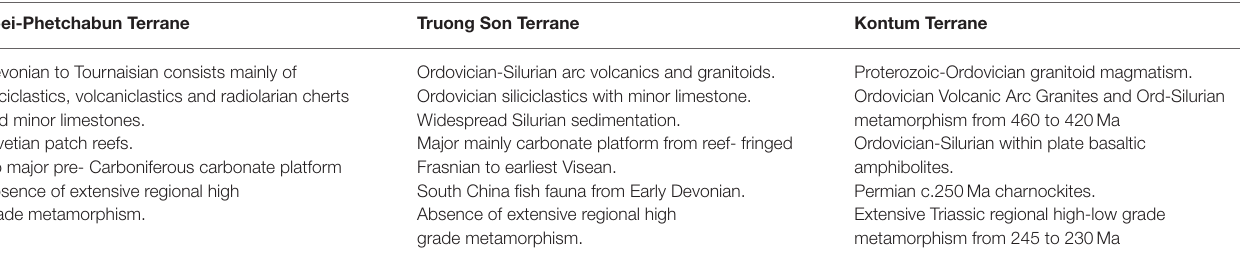
FIGURE 1 | Terrane northwest into Yunnan (China) is based on the existence of widespread Silurian strata which is typical of the Truong Son Terrane rather than the Loei–Phetchabun Terrane (Loydell et al., 2019). The extent of the Loei-Phetchabun and Truong Son terranes under the Mesozoic terrestrial siliciclastics of the Khorat Group on the Khorat Plateau is highly speculative due to a lack of petroleum wells that have penetrated the “mid”-Carboniferous unconformity which is picked on several seismic sections [see Booth and Sattayarak (2011)]. Their extent shown in Figure 1 is, however, plausible based on seismic and other geophysical data ( Figure 3 ). The extension of the Loei Suture eastwards through Cambodia is based on Cheng et al. (2019), Khin et al. (2014), and Udchachon et al. (2018). The extension of the Sra Kaeo-Pailin Suture through Cambodia is based on Udchachon et al. (2018). Note that much of Cambodia is terra incognita geologically and the area in southern Cambodia colored yellow is not assigned to a terrane. Map adapted from Burrett et al. (2014a) and Loydell et al. (2019).